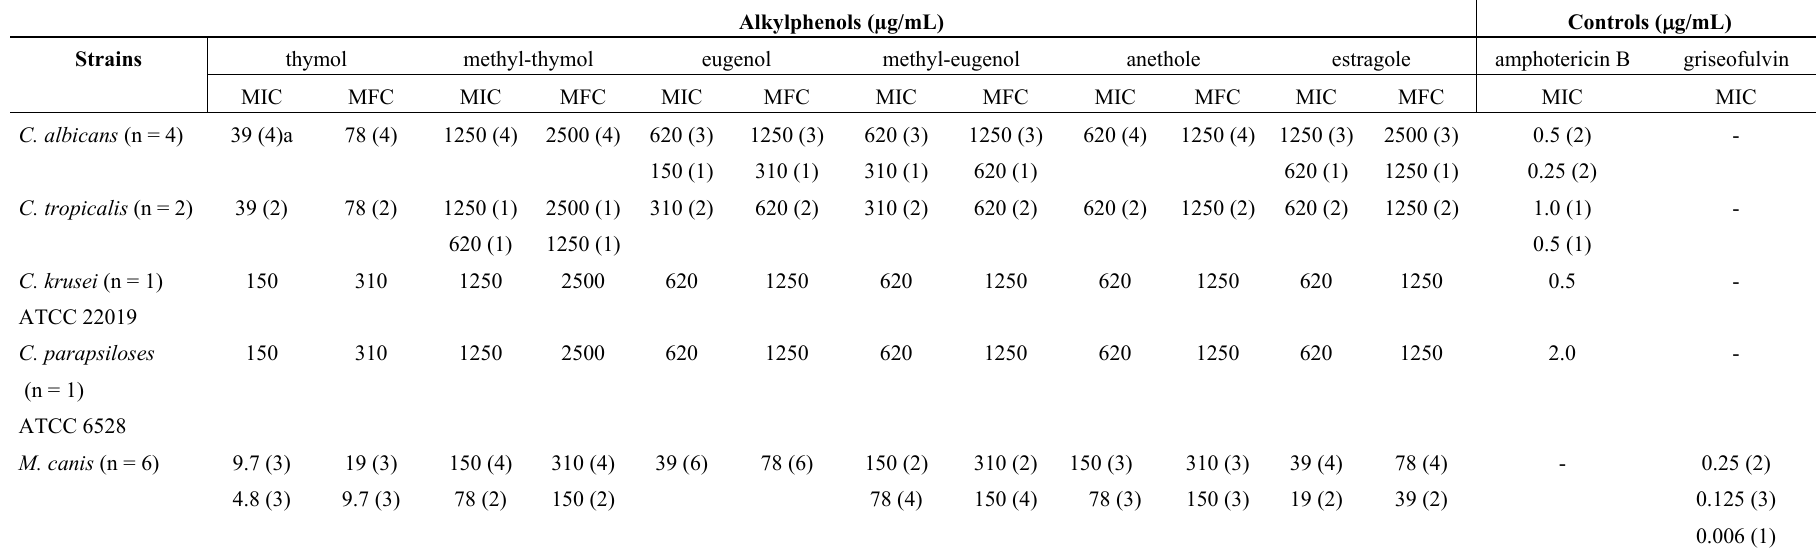
a Represents the number of strains of a species for the MIC and MFC